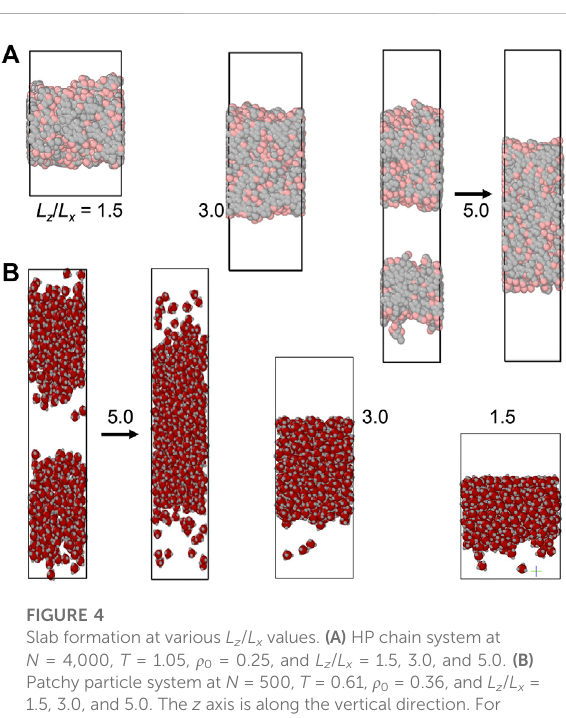
FIGURE 4 Slab formation at various L z / L x values. (A) HP chain system at L z / L x = 1.5, 3.0, and 5.0. (B) N = 4,000, T = 1.05, ρ 0 = 0.25, and Patchy particle system at N = 500, T = 0.61, ρ 0 = 0.36, and L z / L x = 1.5, 3.0, and 5.0. The z axis is along the vertical direction. For each system, the simulation boxes are drawn approximately to scale.Arrows